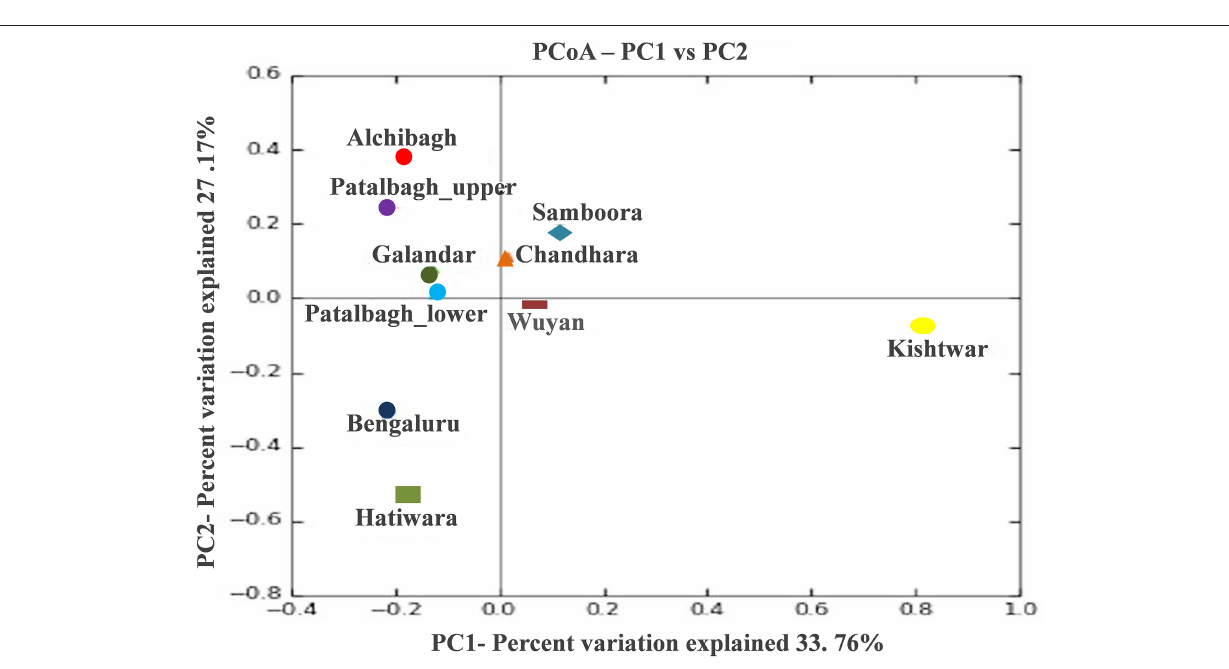
Out of 53 core rhizosphere bacteria identified in the present study, 19 bacteria were also reported previously from